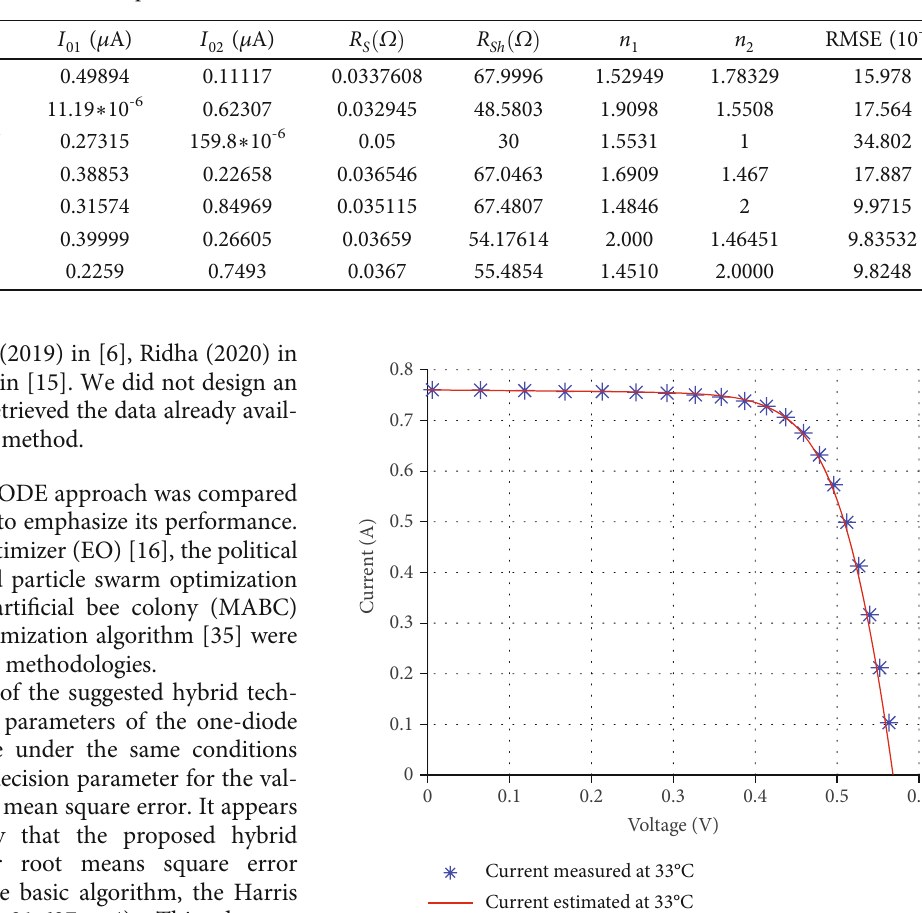
Table 3: Comparison of several methods on the double diode model.